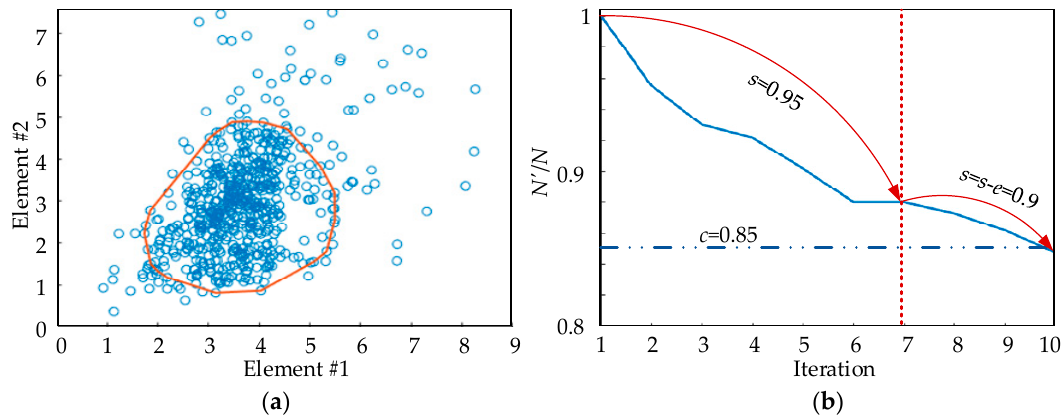
Figure 8. Example of using the iteration algorithm to calculate the confidence field. ( a ) Confidence field of a set of points; ( b ) Iteration process of determining the confidence field.